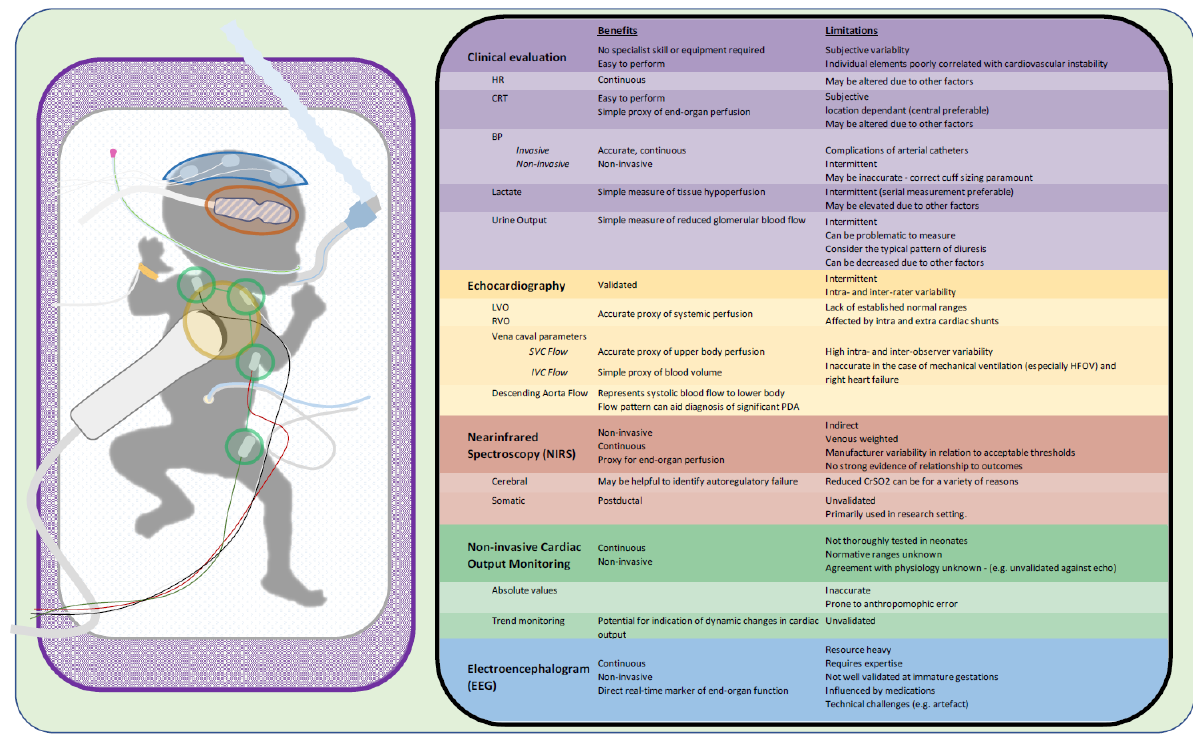
Figure 1. The benefits and limitations of clinical evaluation, echocardiography, NIRS, NICOM, and EEG in the assessment of preterm infants with potential cardiovascular instability.